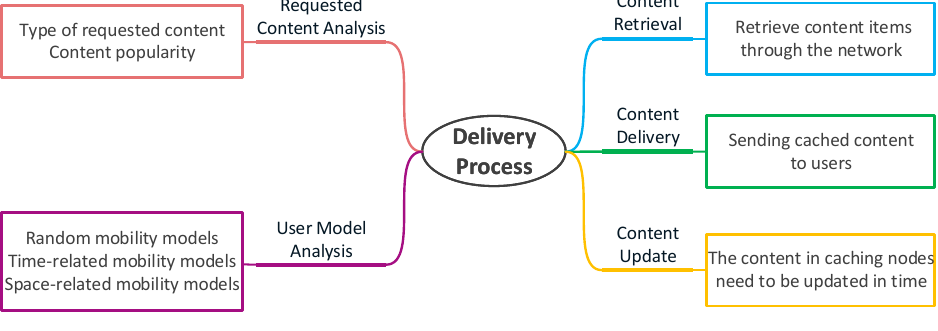
Figure 6. Delivery process.